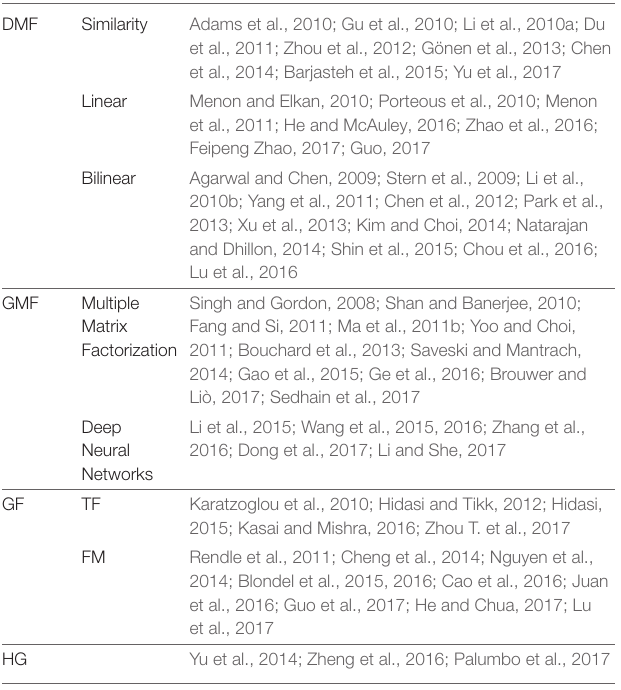
TABLE 5 | Classification of attribute-aware recommender systems.